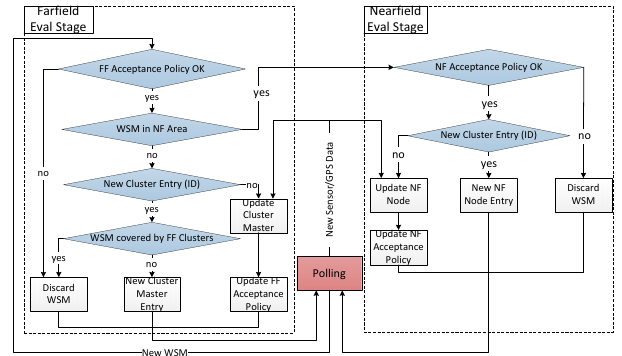
Figure 4: Hybrid Clustering and Hierarchical Eval- uation